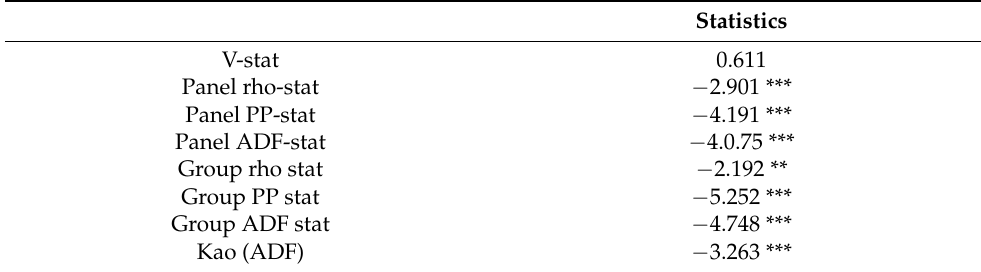
Table 4. Pedroni and Kao panel cointegration tests results.